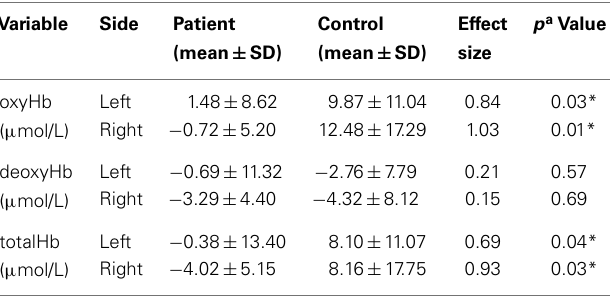
Table 3 | Means and standard deviations of frontal hemodynamic responses in patients and controls during KB